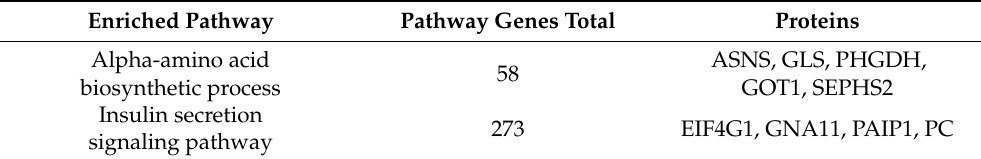
Table 1. Significantly ( p ≤ 0.05) differentially abundant proteins included in significantly ( p ≤